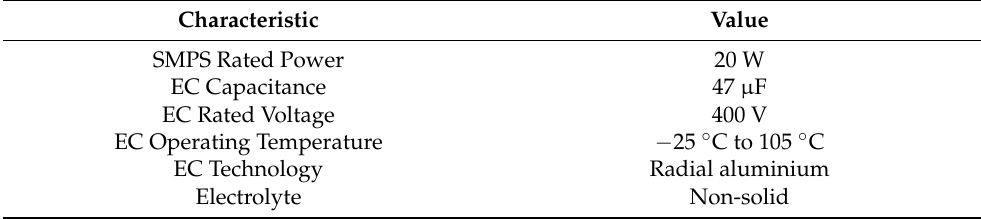
Figure 8. Test board showing mounting of test devices and external resistive loads (capacitors are connected externally to enabled them to be located in laboratory oven). Table 1. Test Device Component